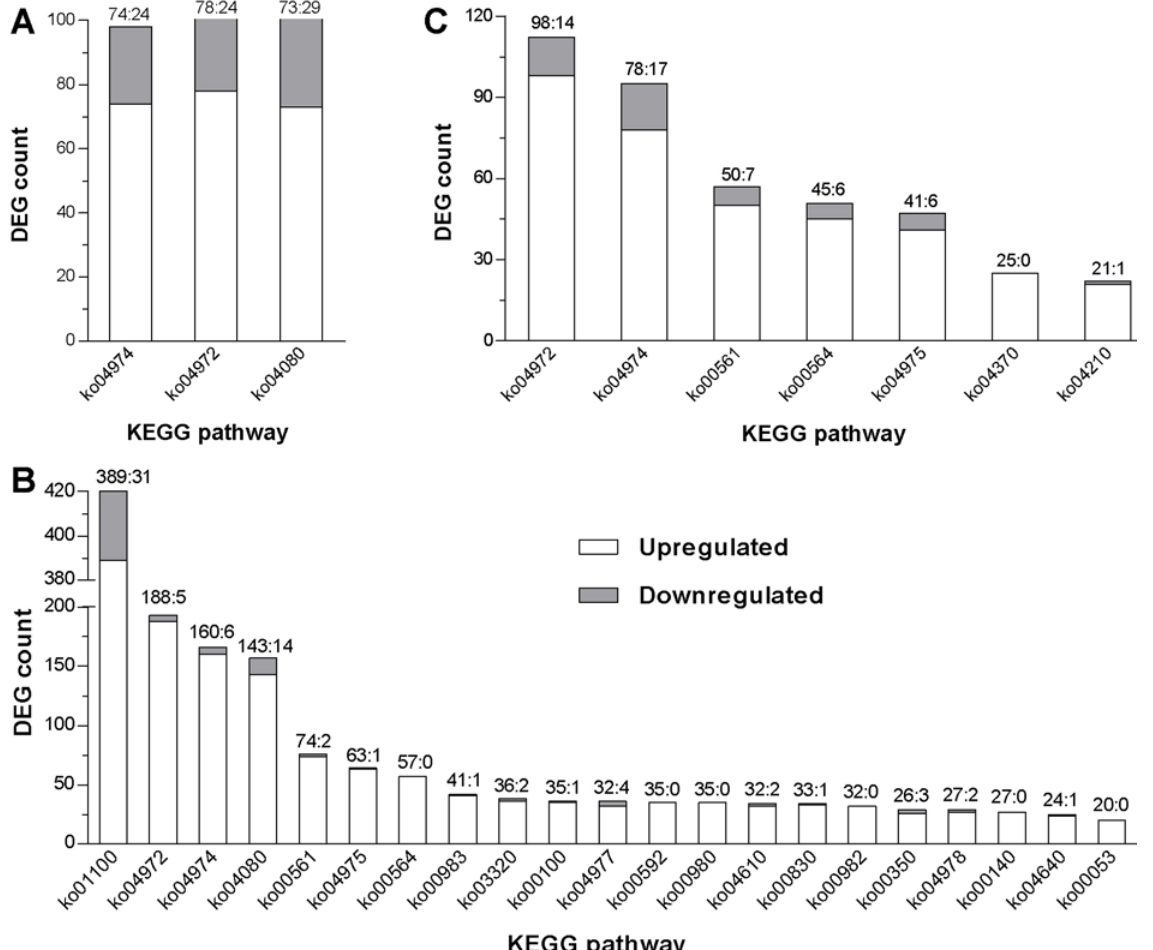
Fig 4. KEGG pathways enriched with P . xylostella DEGs. ( A – C ) Distribution of host DEGs in enriched KEGG pathways at 24, 36 and 48 h post treatment (hpt) of B . bassiana infection versus control respectively. All identified DEGS and enriched KEGG pathways are detailed in Tables B – D in S1